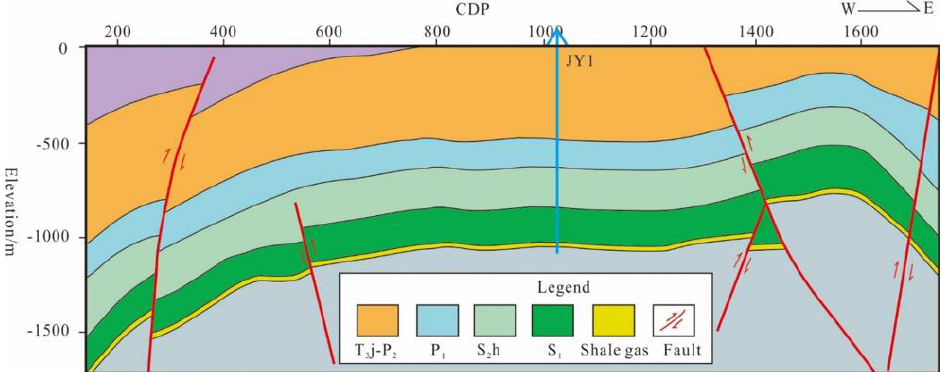
Figure 5. Characteristics of EW trending faults in Jiaoshiba block.